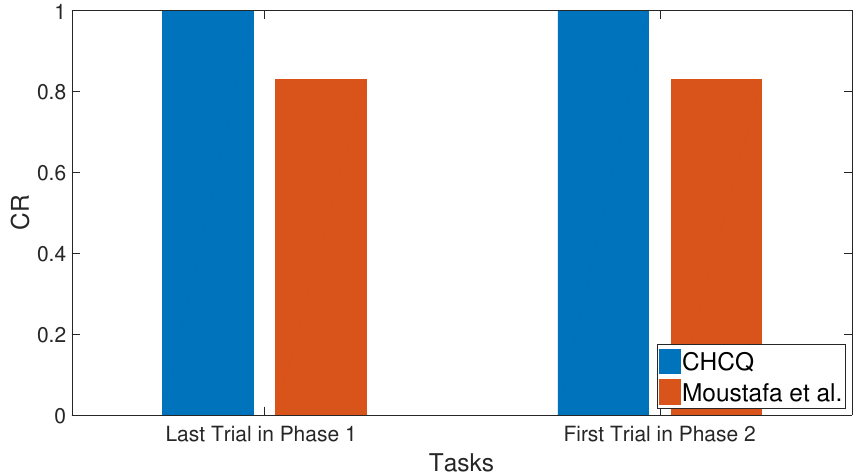
Figure 34. Extended context sensitivity task for the intact